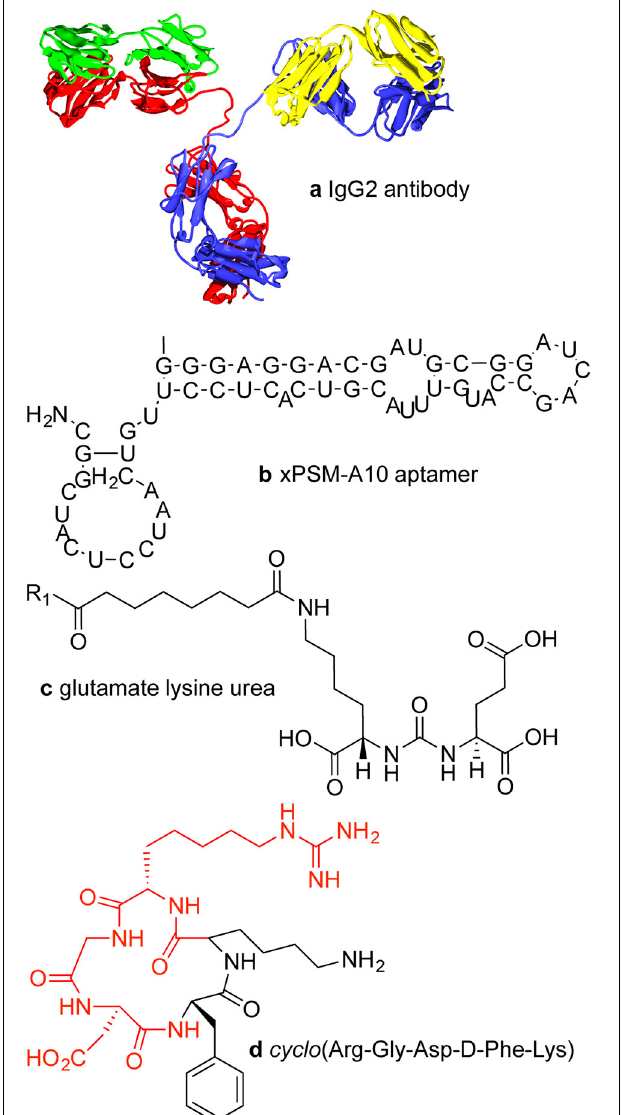
FIGURE 1 | Examples of targeting molecules. (A) Antibodies are typically around 150kDa or about 15 × 5nm with two antigen binding sites. (B) xPSM-A10isa18.5kDaaptamerwithabindingaffinityofabout10 − 8 M − 1 for the extracellular portion of the prostate-specific membrane antigen (PSMA) (Lupold et al., 2002). (C) The glutamate lysine urea small molecule targets PSMA (473Da) (Banerjee et al., 2008). (D) The RGD peptide sequence (604Da) binds to cell surface integrins, upregulated in many tumor